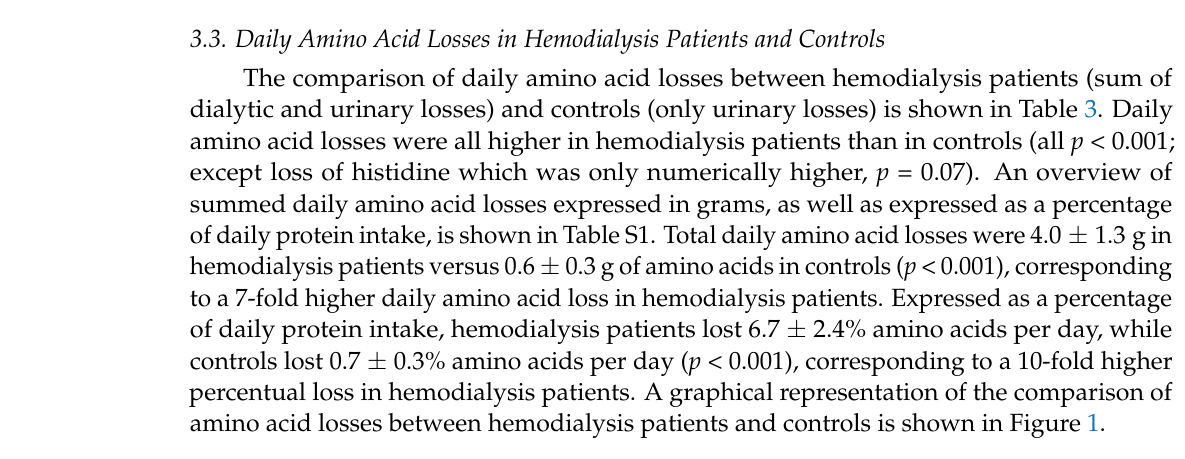
Table 3. Comparison of daily amino acid losses between hemodialysis patients and